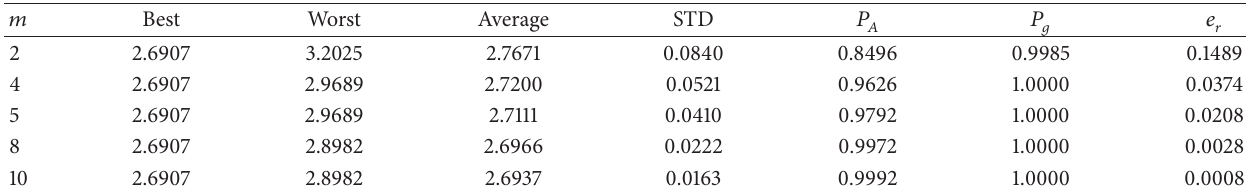
Table 1: Experimental comparison for ant number 𝑚 .